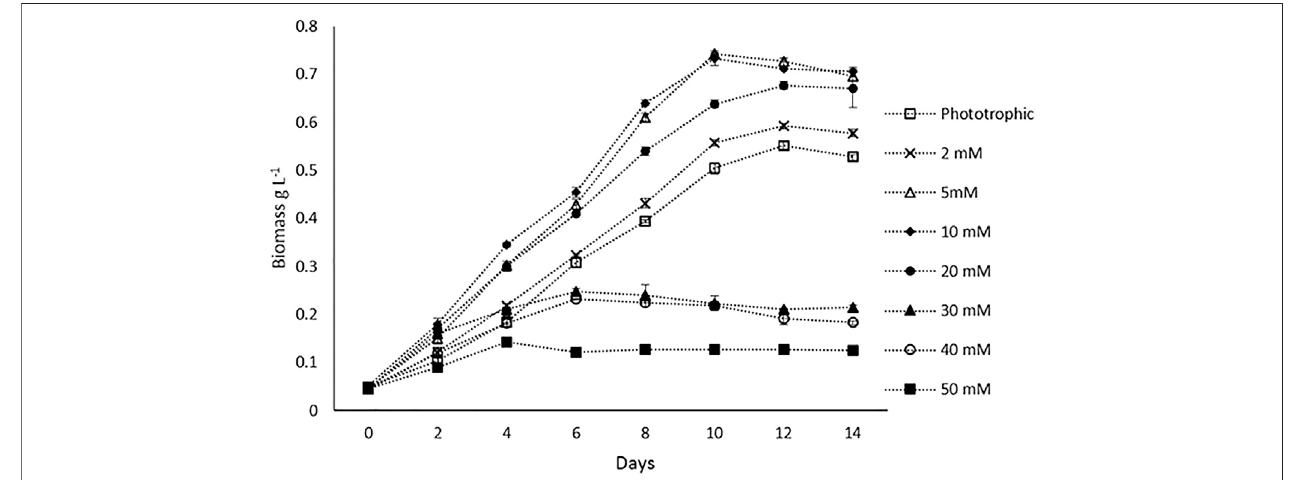
FIGURE 1 | Biomass (DCW) pro fi les of H. lacustris under phototrophic and mixotrophic cultivation in the batch